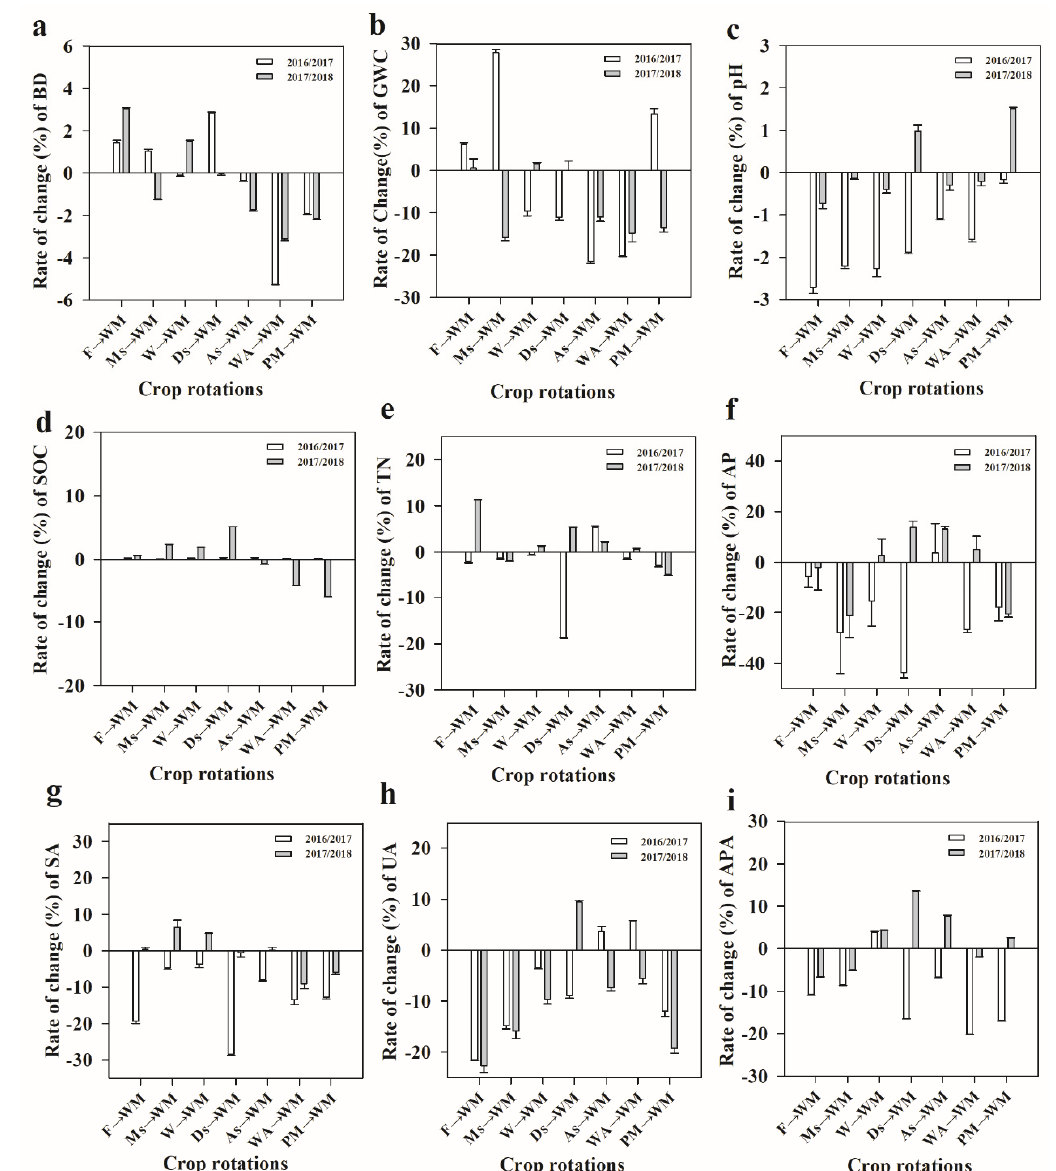
Figure 2. Rate of change of selected soil health indicators as influenced by different crop rotations compared with WM → W rotation as a baseline. WM → WM, winter wheat–summer maize → winter wheat–summermaize; F → WM,fallow → winterwheat–summermaize; Ms → WM,springmaize → winter wheat–summer maize; W → WM, winter wheat → winter wheat–summer maize; Psw → WM, sweet potato → winter wheat–summer maize; Pns → WM, spring peanut → winter wheat–summer maize; maize → winter wheat–summer maize. ( a ) BD, bulk density; ( b ) GWC, soil gravimetric water content; ( c